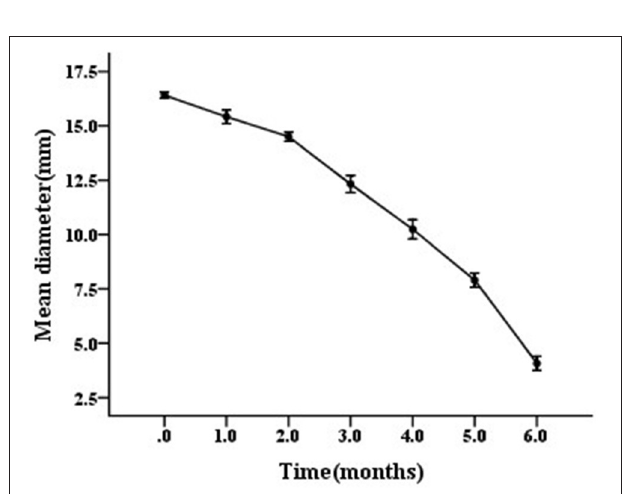
still produce β -hemolysis on rabbit blood agar, caseinase, dnase, and gelatinase.